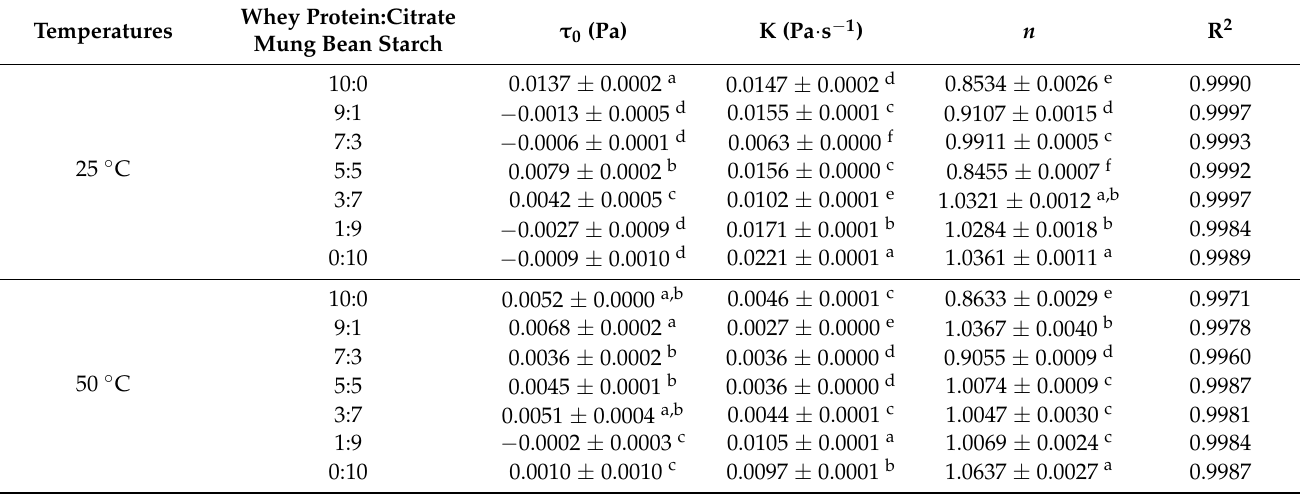
Table 1. Fitting results of Herschel–Bulkley equation for whey protein–citrate starch–capsaicin